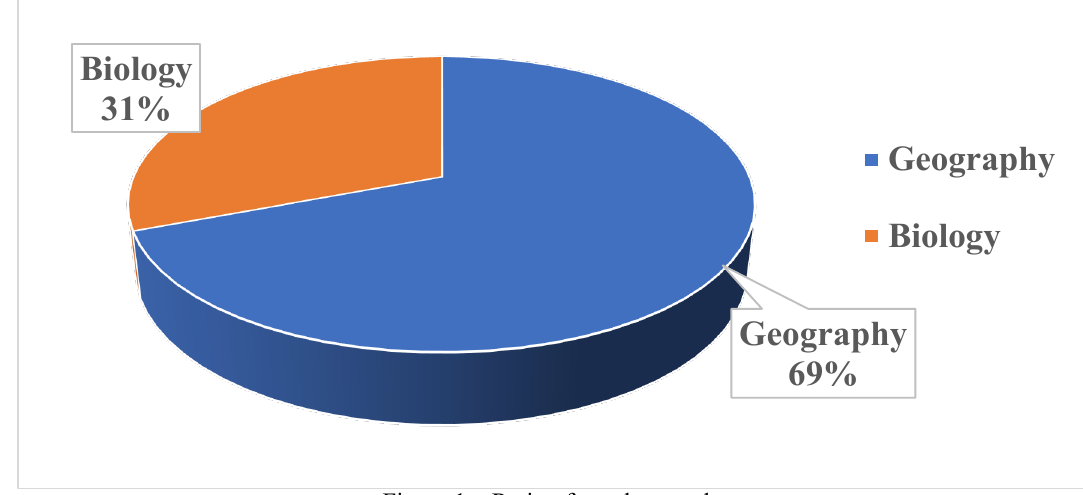
Figure 1 – Ratio of word